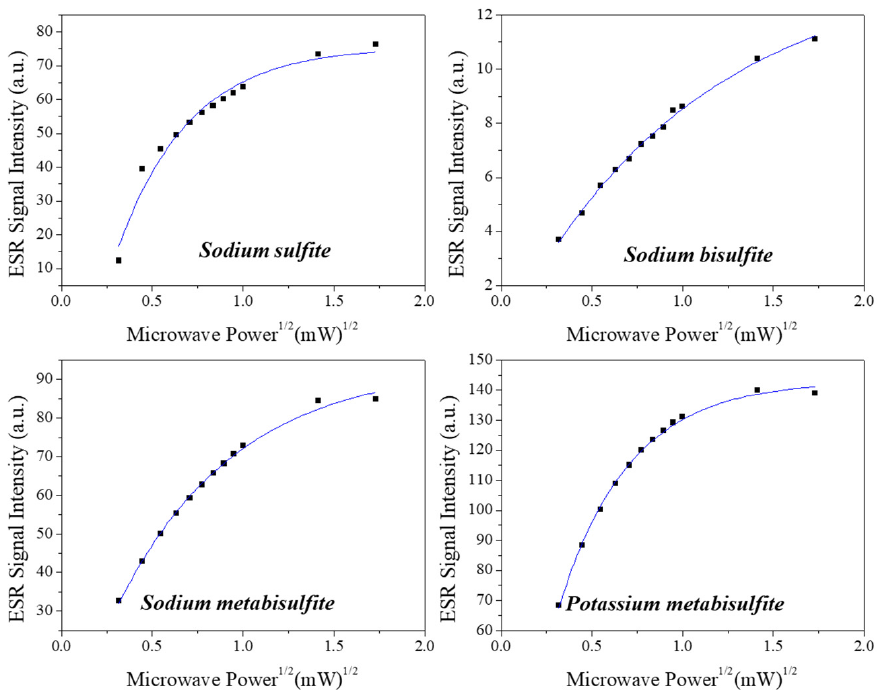
Figure 3. ESR signal amplitude as a function of the microwave incident power at the resonant cavity.